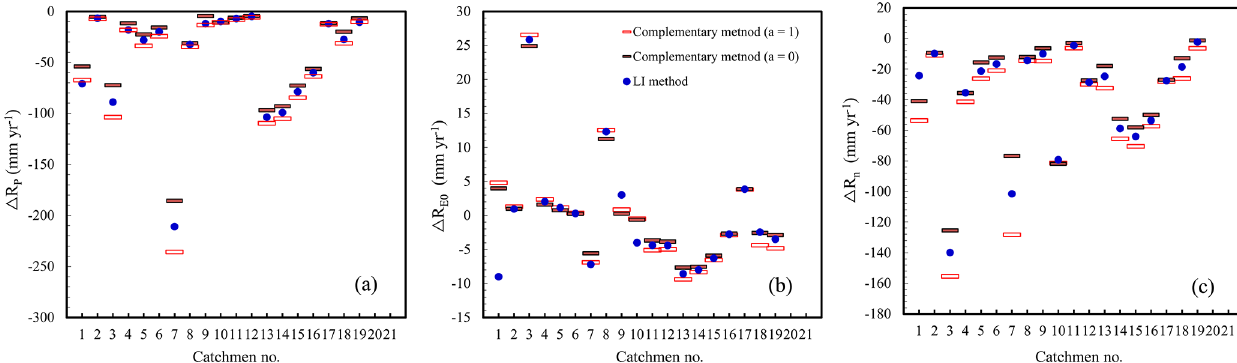
Figure 7. Comparisons of (a) (cid:49)R P , (b) (cid:49)R E method. According to Zhou et al. (2016), (cid:49)R P , (cid:49)R E